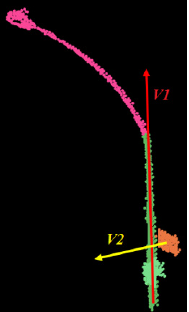
Figure 2. The relative angle between the principal direction of a pole and the normal of an attachment Size. This feature is designed for planar attachments. Size is the area of an attachment’s concave shape after it being projected to its normal direction. This feature is used to distinguish different types of traffic functional signs. Ratio of height to length. The ratio of height to length gives the proportion between the height of attachments and the largest variation in the horizontal plane. This feature is utilized to differentiate street signs and other signs.